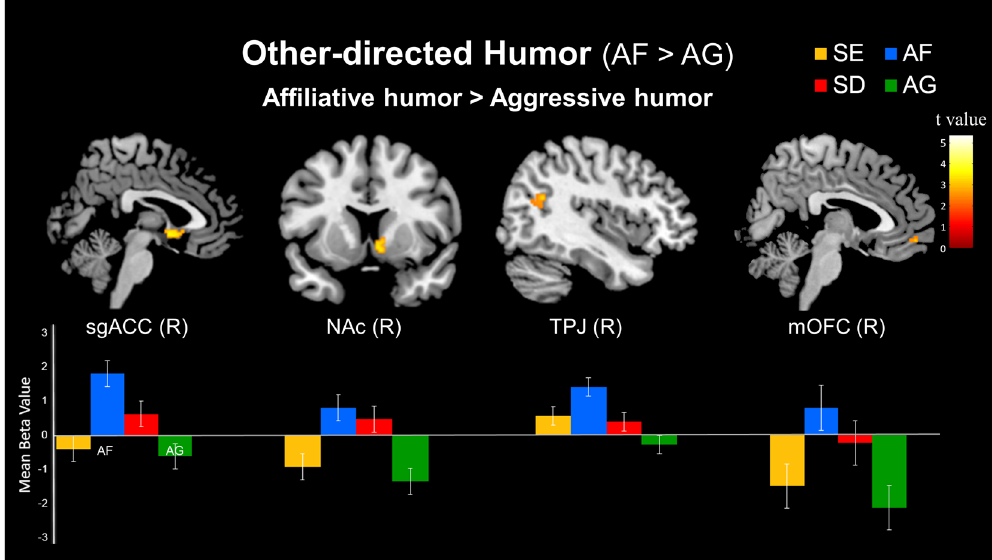
Figure 2. Simple effects of the differential neural mechanisms related to other-directed humor. (Top) Stronger responses to affiliative humor (AF) than to aggressive humor (AG) in the right subgenual anterior cingulate cortex (sgACC), right nucleus accumbens (NAc), right temporoparietal junction (TPJ), and right medial orbitofrontal cortex (mOFC). (Bottom) Parameter estimates (SPM betas) are plotted for these four regions. Standard error bars are